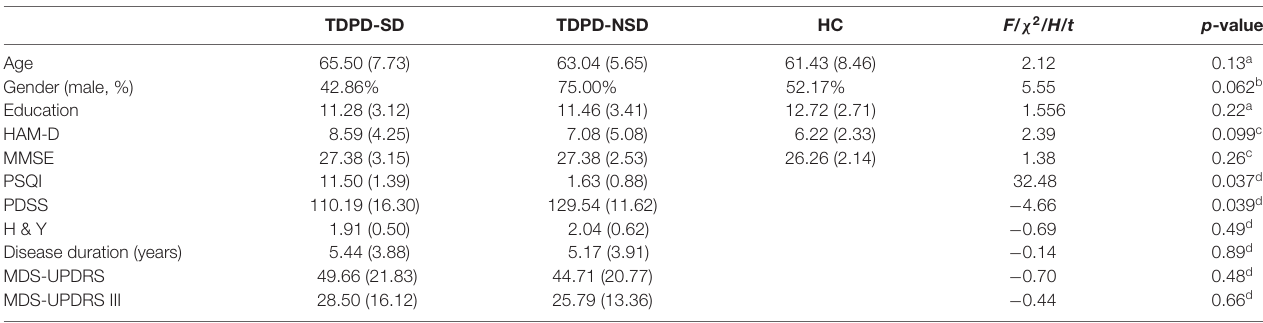
TABLE 1 | Demographic and clinical characteristics of 56 TDPD patients and 23 healthy